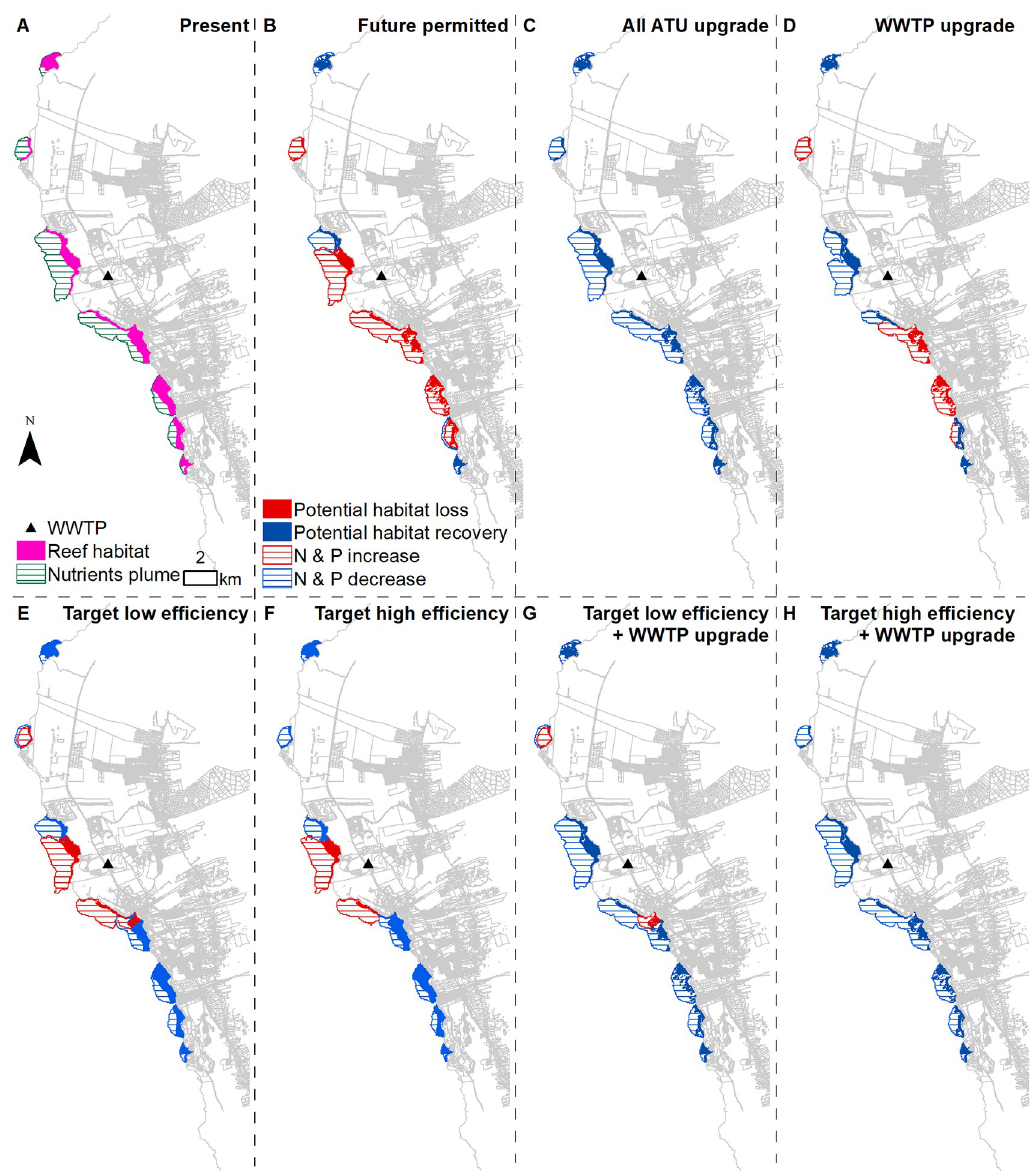
Fig 7. Marine habitat potential impacts. Maps display (A) the current exposure of marine habitat to SGD nutrients and (B-H) potential habitat loss or recovery due to the change in water quality under all scenarios.